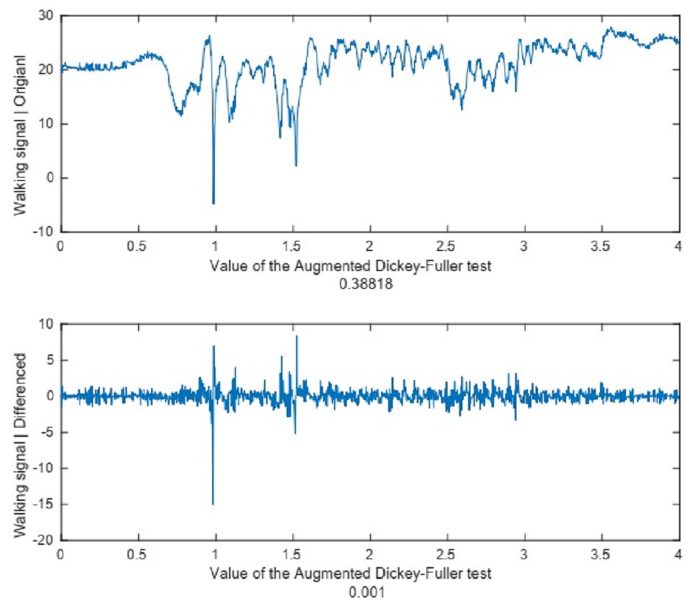
Figure 10. The effect of differencing on the ADF test.